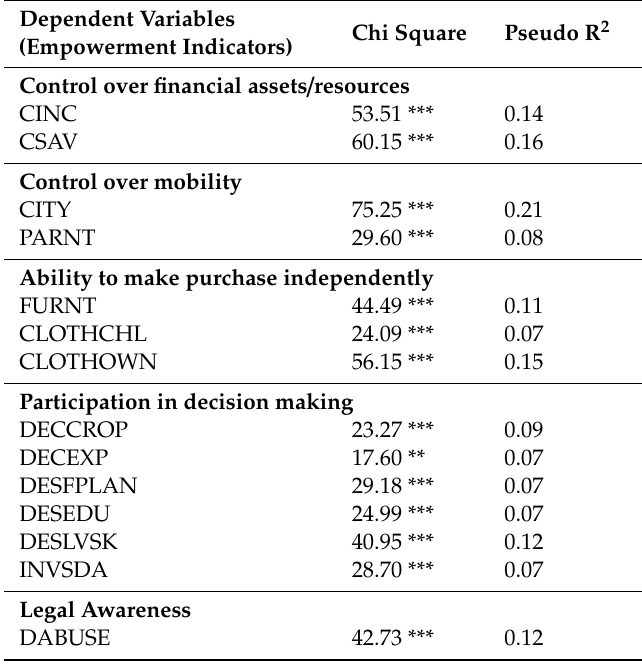
Table 6. Goodness-of-fit statistics for the logit model for di ff erent women empowerment indicators. Dependent Variables (Empowerment